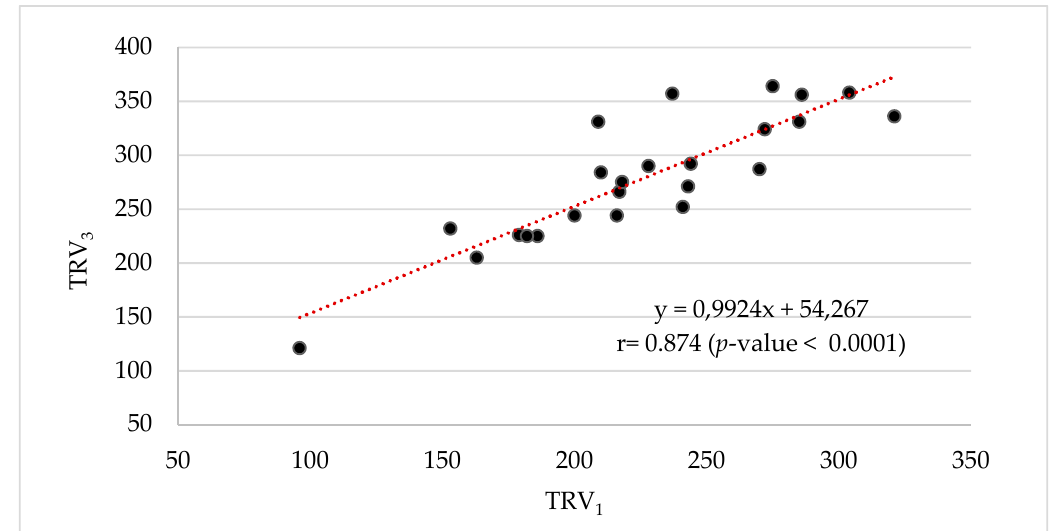
Figure 11. Linear regression graph between TRV 3 and TRV 1 .